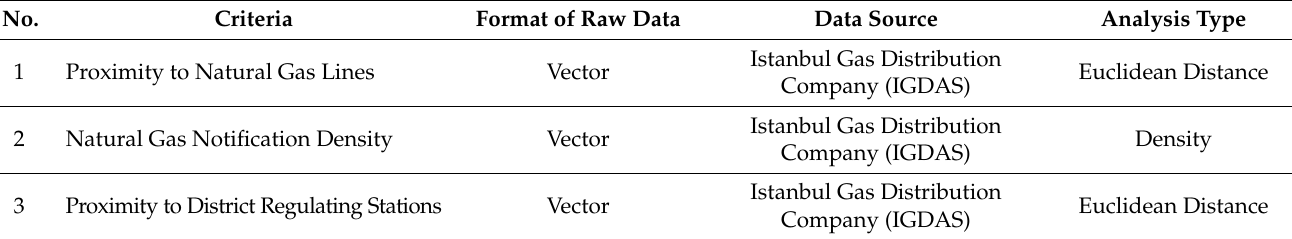
Figure 8. Triangular fuzzy number, A = ( l , m , u ). The l, m, and u values represent triangular fuzzy numbers. l = lowest value, m = most likely value, and u = highest value. The membership function of a triangular fuzzy number is represented as A = ( l , m, u ).